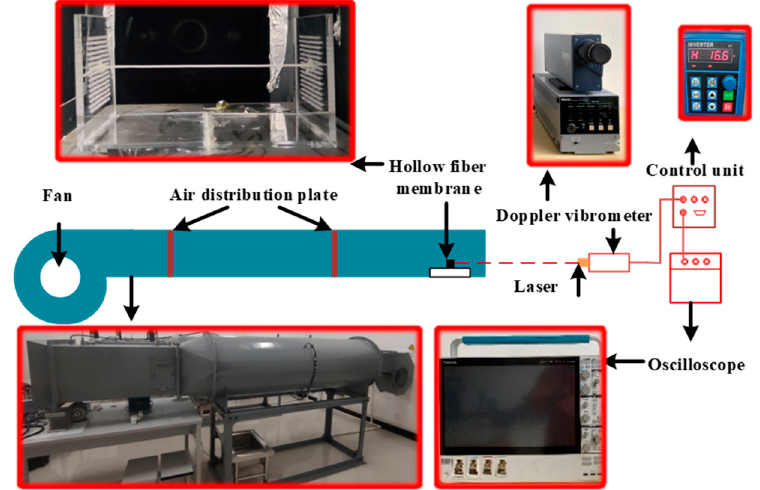
Figure 3. Hollow fiber membrane fixation module.